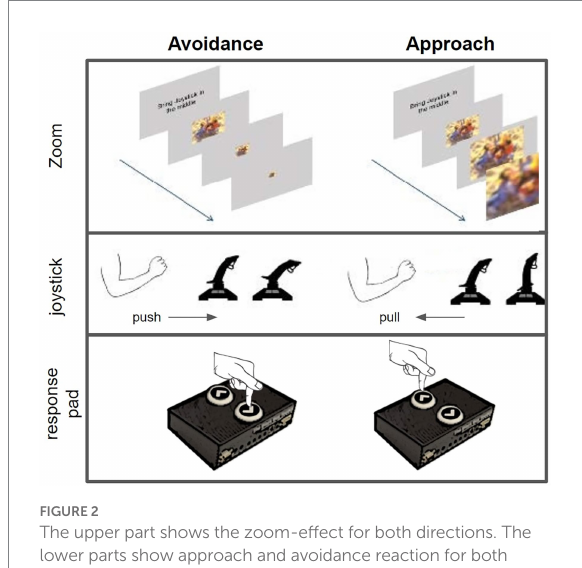
FIGURE 2 The upper part shows the zoom-effect for both directions. The lower parts show approach and avoidance reaction for both devices (joystick and response pad). This figure is partly reused from Czeszumski et al.